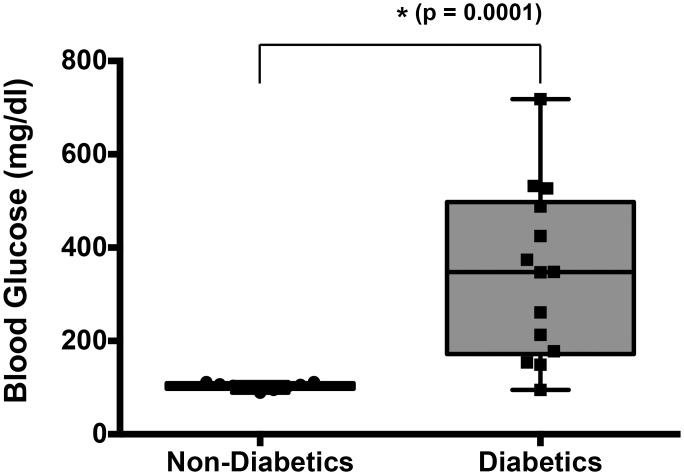
Blood glucose levels in diabetic and non-diabetic dogs.Blood glucose was measured as described in Materials and Methods. Box plot shows blood glucose concentrations for non-diabetic and for diabetic dogs (median and the 25th to 75th percentiles; whiskers represent outliers), as well as individual data points. The blood glucose concentrations in dogs with diabetes were significantly higher that those in dogs without diabetes (p = 0.0001, Mann Whitney test).